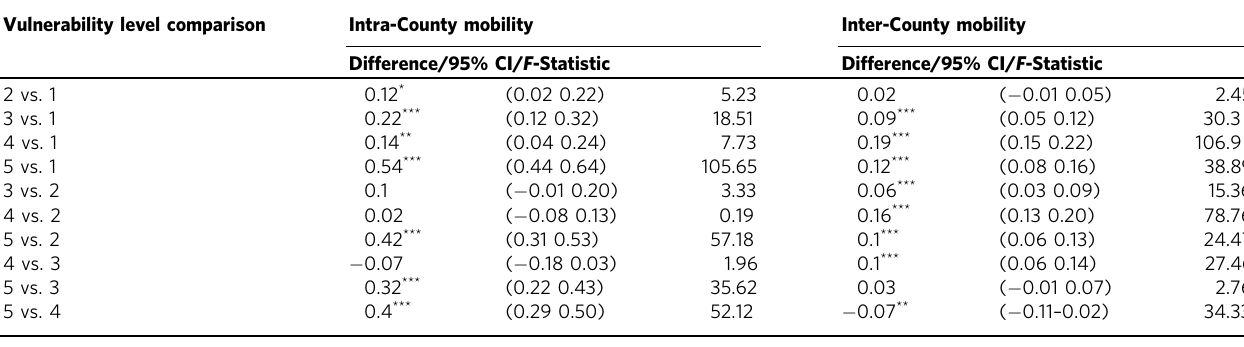
Table 5 Differences in the mobility coef fi cients between two different vulnerability levels based on analysis of variance (ANOVA)